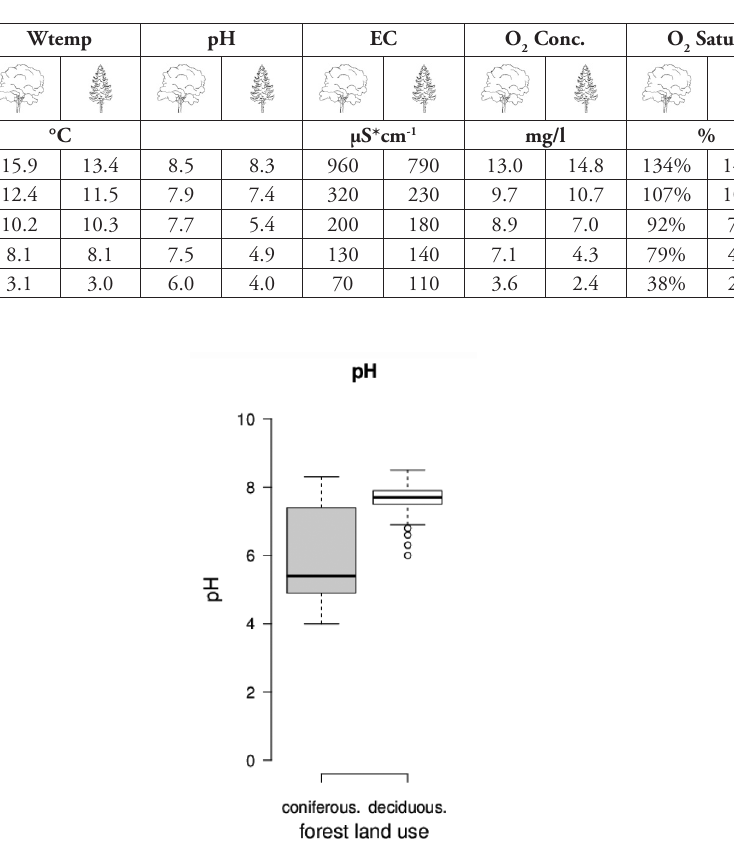
Table 3. Hydro-physical-chemical measurements of deciduous forest and coniferous forest land cover.